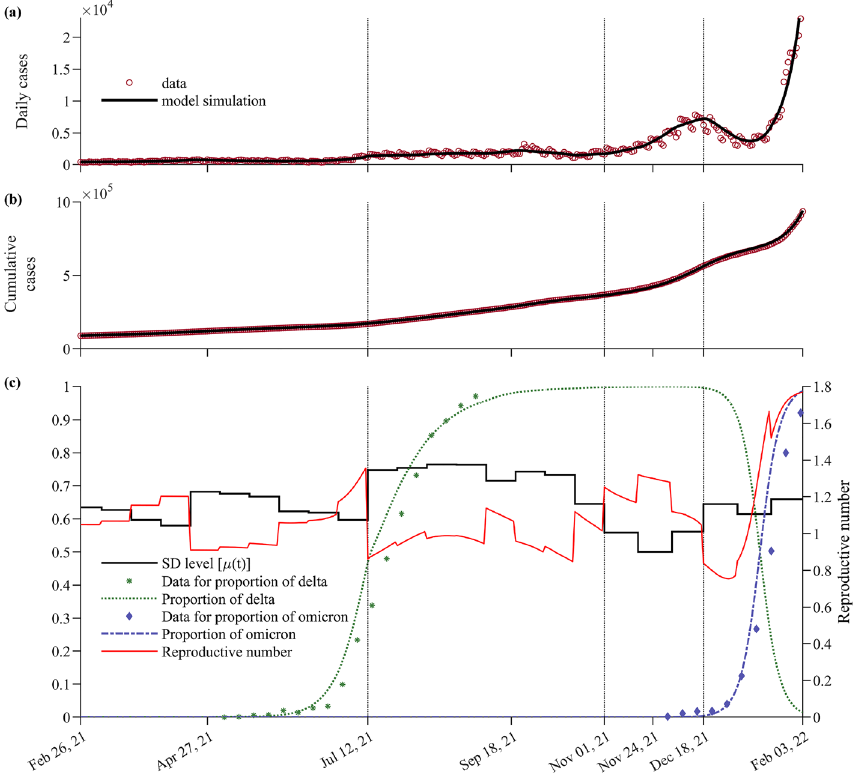
Figure 1. Parameter-fitting results for µ( t ) from February 26, 2021 to February 3, 2022. The vertical dotted lines depict the transition between the different SD policies. Panels ( a,b ) show the best fit of the model to the daily and cumulative confirmed cases, respectively. The red circles represent the data on daily and cumulative cases. Panel ( c ) shows the estimated values of µ( t ) (black curve), the effective reproductive number R ( t ) (red curve), and the proportion of Delta and Omicron variants among the confirmed cases (green and blue curves, respectively). The green and blue circles indicate the data on the proportion of Delta and Omicron infections among tested samples, respectively.